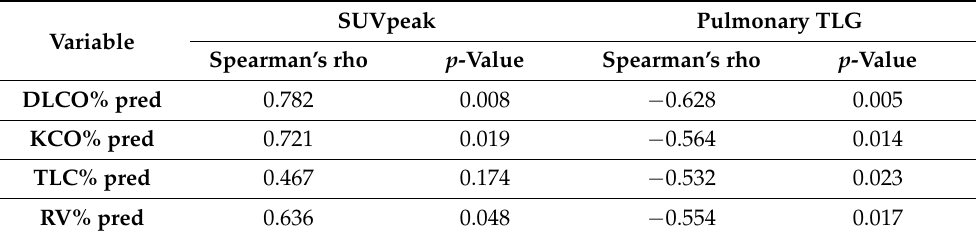
Table 3. Bivariate correlations of volumetric [ 18 F]FDG PET/CT parameters and respiratory function parameters in the short-term